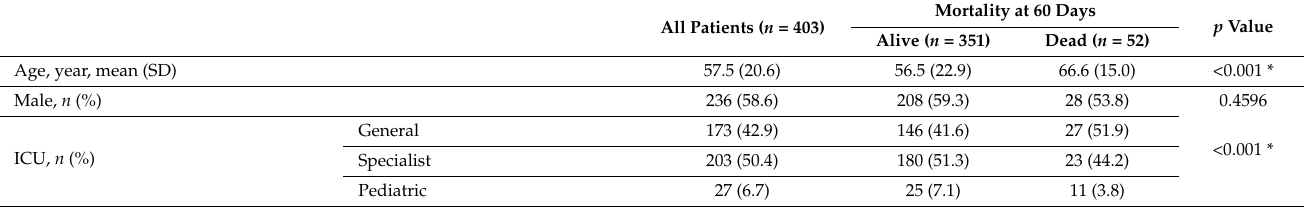
Table 5. Characteristics of patients according to mortality (note: total number of patients is 403, as in 32 patients outcome data were